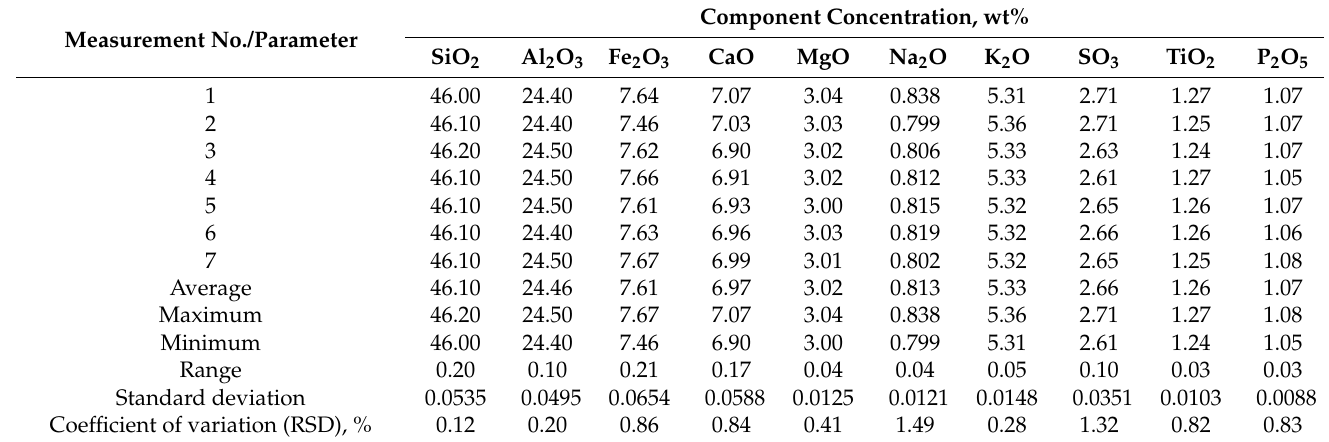
Table 7. The reproducibility of the results obtained with the SQX software for coal ash sample. Component Concentration, Measurement No./Parameter